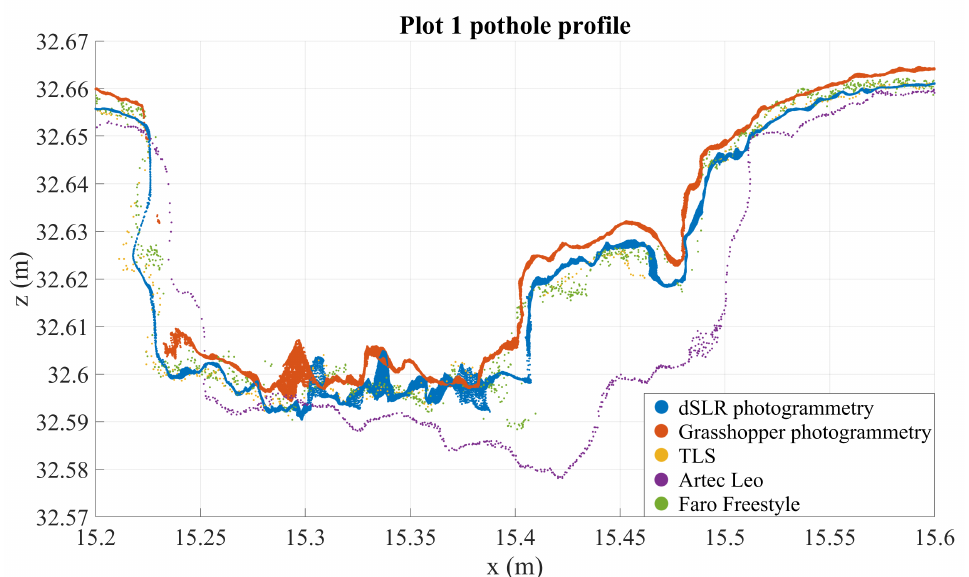
Figure 8. Three mm deep profiles of plot 1 as measured by all instruments in an arbitrary coordinate